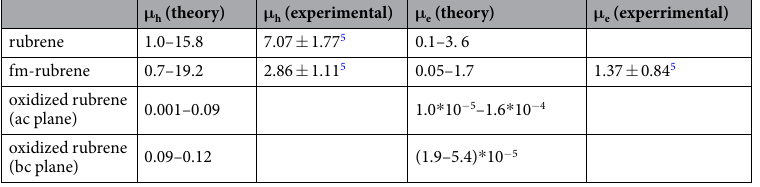
Table 3. Theoretical hole-diffusion mobilities ( μ h ) and electron-diffusion mobilities ( μ e ) of rubrene, fm-rubrene and oxidized rubrene at room temperature (T = 300 K), and some experimental charge-transfer mobility values.